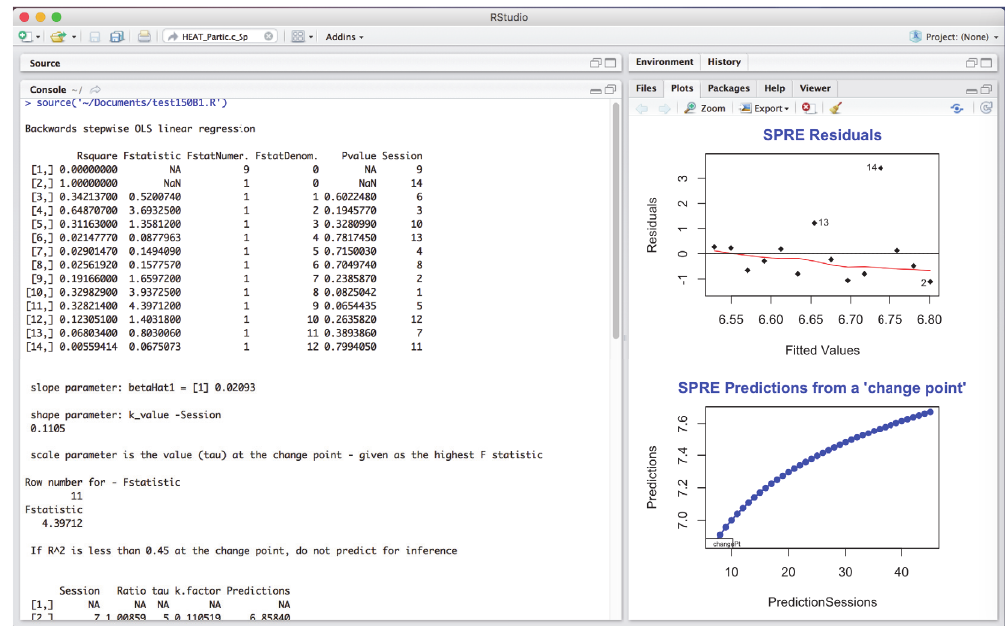
Figure 6: HEAT residuals analysis for Partic.c sensory processing in